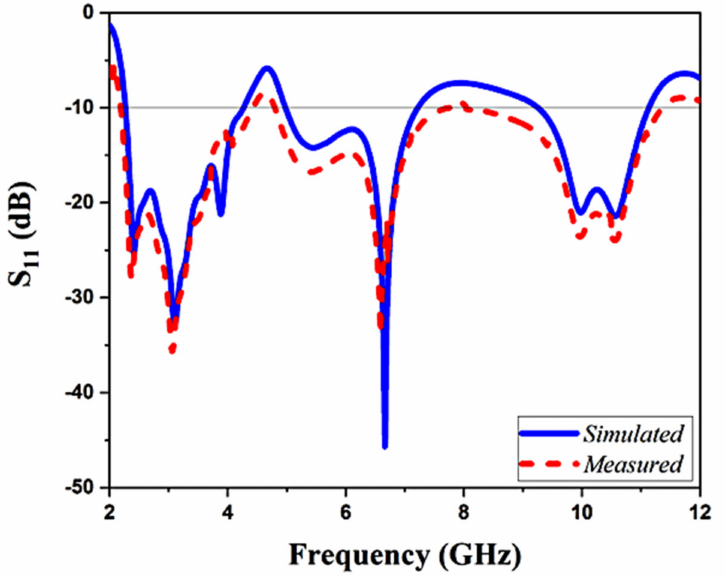
Figure 11. Simulated and measured reflection coefficient for the designed Sierpinski hexagonal- shaped fractal